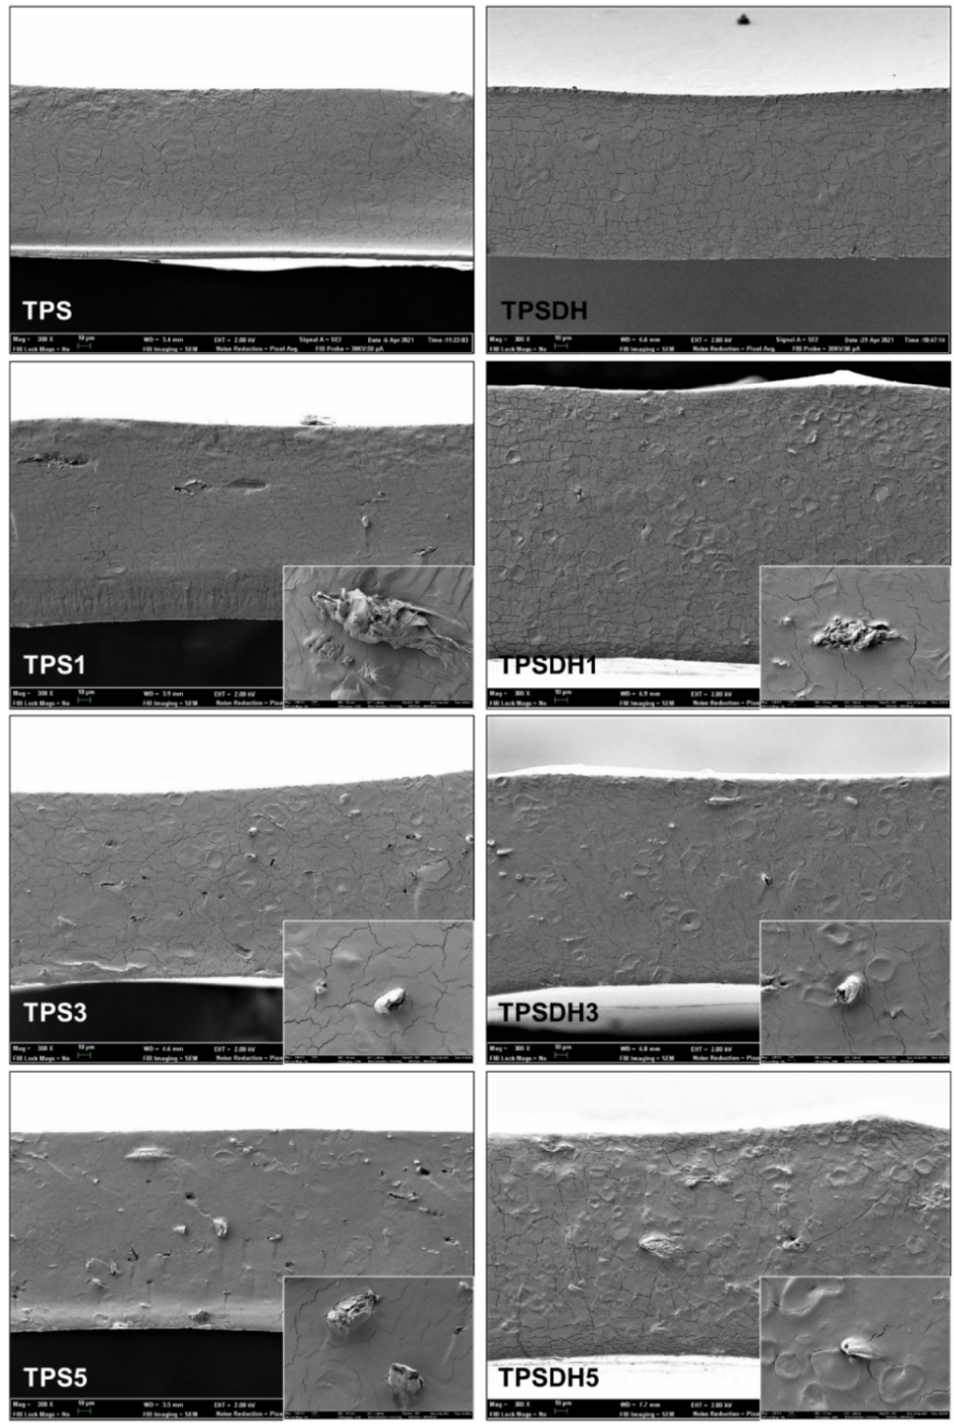
Figure 4. Field emission scanning electron microscope (FESEM) micrographs of the fracture surfaces of thermoplastic starch (TPS) and TPS modified by dry heating (TPSDH) films with contents of cellulose microfibers (CMFs) of 1 wt% (TPS1, TPSDH1), 3 wt% (TPS3, TPSDH3), and 5 wt% (TPS5, TPSDH5). Images were taken at 300× with insets at 2000×.